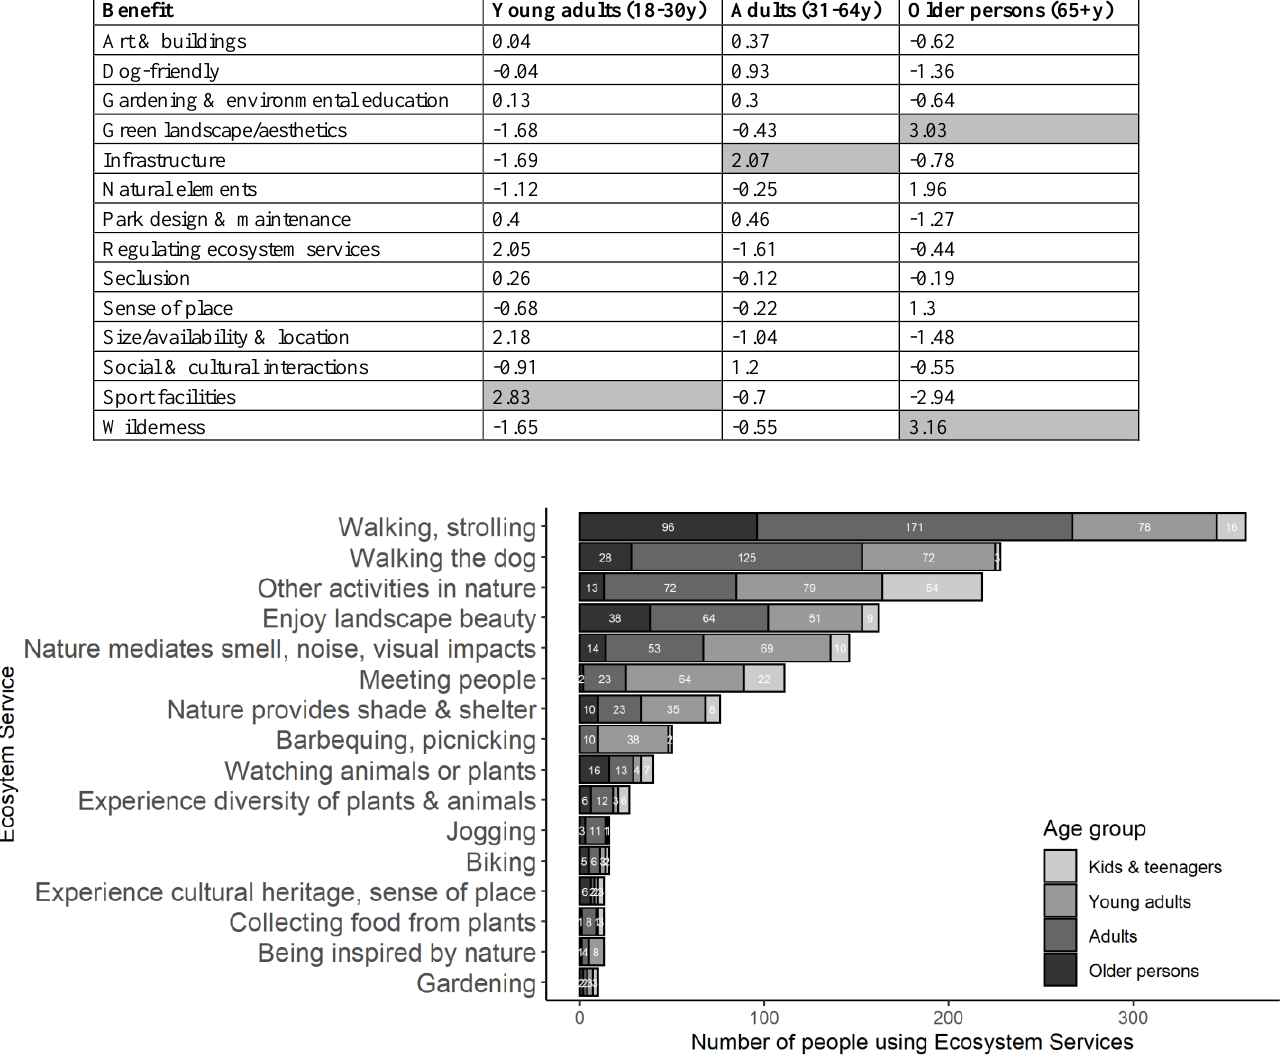
Table A1.2: Pearson’s residuals of chi-square test for benefits in urban parks. Positive values mean a positive association between age group and benefit, negative values mean negative association between age group and benefit (p<0.001). Highest positive residuals are marked in grey.